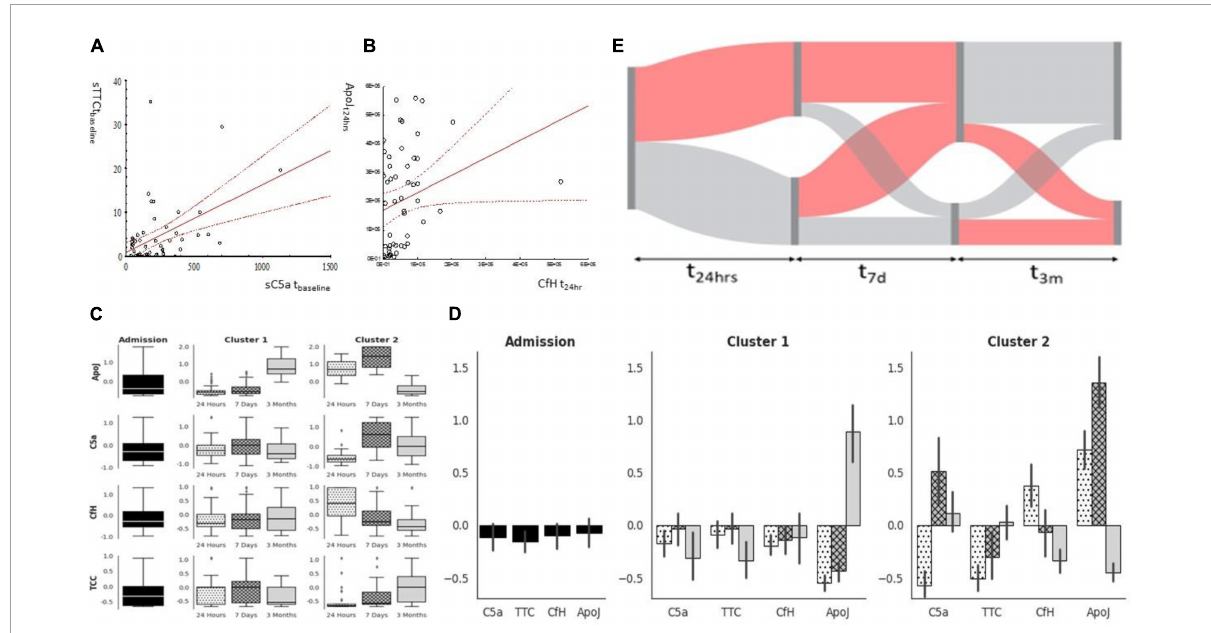
FIGURE3 Complement factors milieu after cardiac surgery. C5a and TTC correlated strongly at the baseline (A) , while protective factors (ApoJ CfH) correlated at t 24 h (B) . While factors were analyzed using clustering, two subgroups emerged: cluster#1 can be characterized by a significant increase in ApoJ at 3 months while cluster#2 is characterized by significant activation of sC5a later after surgery concomitant ApoJ (C,D) . Patients’ complement milieu was not stagnant as complement activation characteristics moved between clusters (E) .